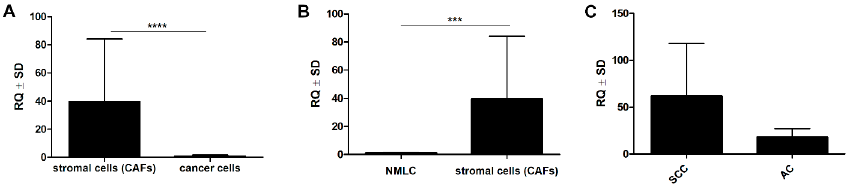
Figure 10. Significantly higher mRNA expression of periostin (POSTN) in the microdissected (LCM) stromal cells (CAFs) as compared to their expression in ( A ) cancer cells (**** p < 0.0001) and ( B ) non-malignant lung cells (NMLC) (*** p < 0.001). ( C ) Comparison of mRNA periostin (POSTN) expression in squamous cell cancer (SCC) and its expression in adenocarcinoma (AC); Mann–Whitney U test.